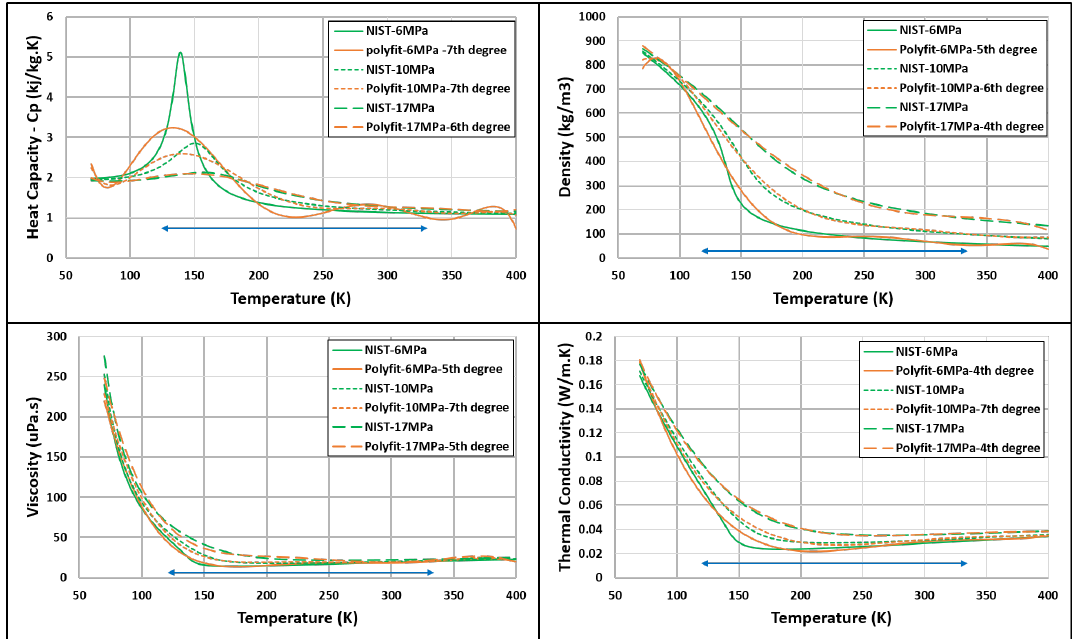
Figure 8. Plots of polynomial functions of thermophysical property (heat capacity, top-left ; density top-right ; viscosity, bottom-left ; thermal conductivity, bottom-right ) obtained from polynomial fitting of NIST data, against temperature. The range of temperatures encountered in the simulation is within the double arrow headed blue